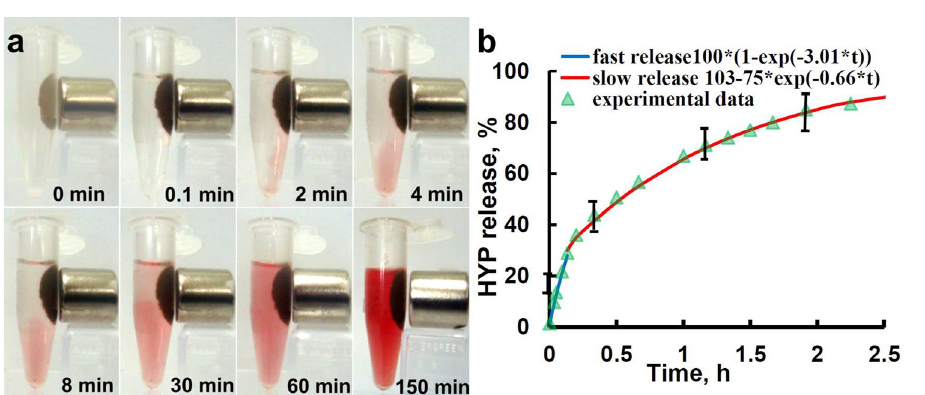
Figure 3. Time-dependent hypericin release from HYP-MCZ particles. ( a ) Photographs of continuos release of HYP molecules from HYP-MCZ micro-particles to ethanol–water 50% solution. ( b ) two-exponential kinetics of HYP release from MCZ pores measured by absorption